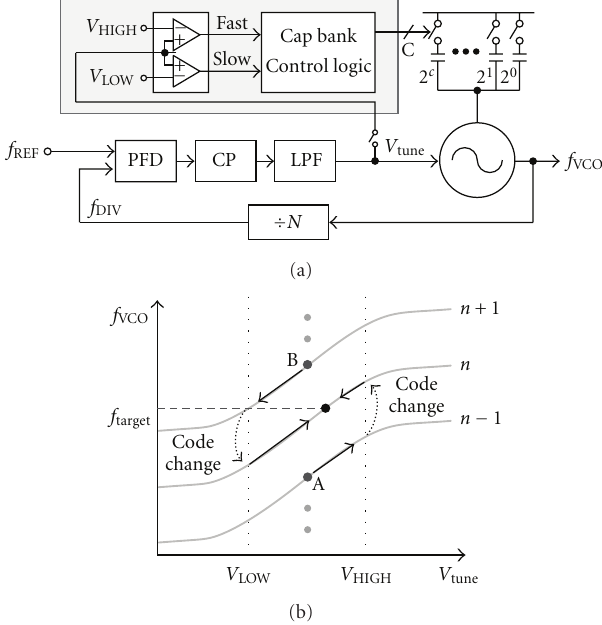
Figure 2: VCO frequency calibration by V tune monitoring. (a) Ar- chitecture. (b) Operation principle